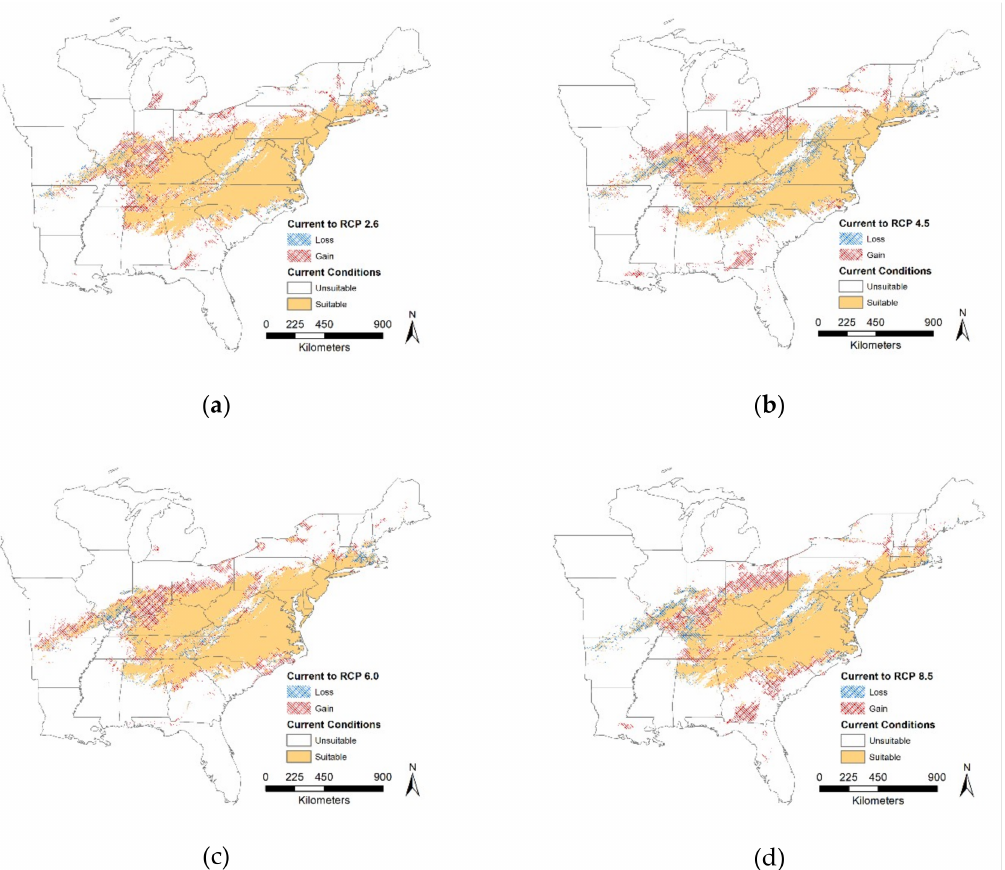
Figure 2. Predicted current (unsuitable and suitable) combined with future loss (in blue) and gain (in red) habitat for T. c. carolina . Future predictions are based on four emission scenarios for 2050 with changes from current to ( a ) 2050 Representative Concentration Pathway (RCP) 2.6; ( b ) 2050 RCP 4.5; ( c ) 2050 RCP 6.0; ( d ) 2050 RCP 8.5.